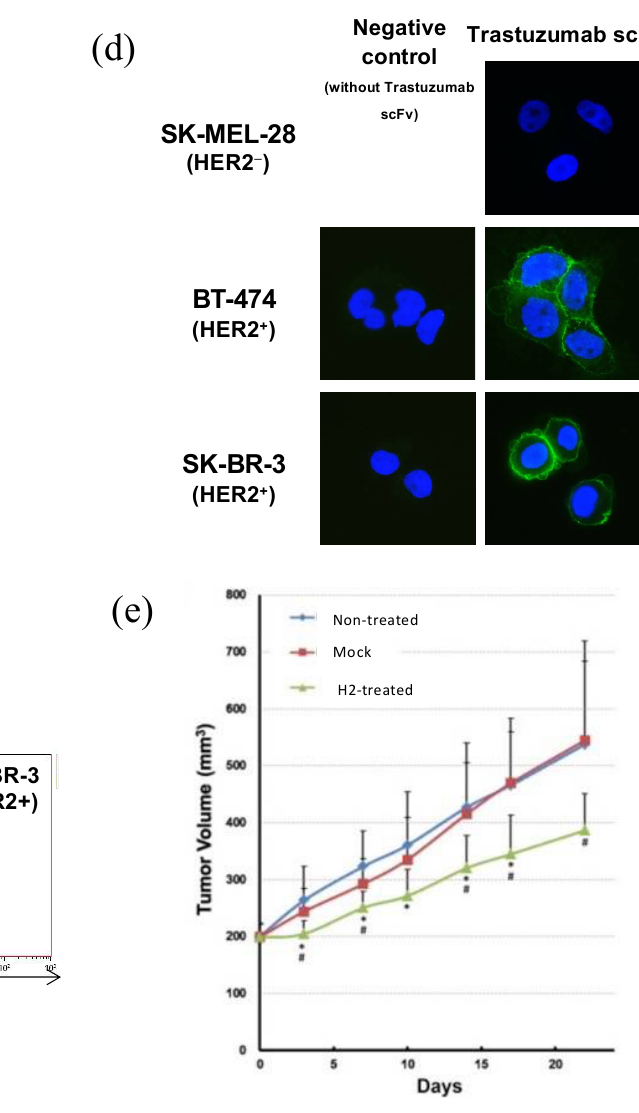
Figure 5. ( a ) Structure of the pH1 and pH2 plasmids. ( b ) Molecular size of the trastuzumab scFV produced by Bifidobacterium . Results for H1 scFv are shown. Regarding H2, identically sized scFv was confirmed at a markedly higher expression amount. ( c ) FACS analysis. SK-MEL-28 (HER2−), BT-474 (HER2 +/−), and SK-BR-3 (HER2+) cells were stained with His-tag-purified trastuzumab scFv. Blue line: control (buffer alone). Red line: stained with trastuzumab scFv from H2. ( d ) Immunostaining of cultured cells by His-tag-purified trastuzumab scFv from B. longum H2. Immunofluorescent staining. Blue: nucleus. Green: stained with trastuzumab scFv from H2. Right panels: stained with trastuzumab scFv. Left panels: negative control (without trastuzumab scFv). Original magnification of all images was x400. ( e ) Growth suppression of a human HER2(+) carcinoma transplanted into nude mice by recombinant Bifidobacterium H2. B. longum mock and H2 were i.v. administered to NCI-N87 human gastric cancer tumor-bearing mice twice a week. Mean ± standard deviation values of 8 mice. *: p < 0.05 versus non-treated group, #: p < 0.05 versus mock-treated group. This figure was adopted from a previous study [58].